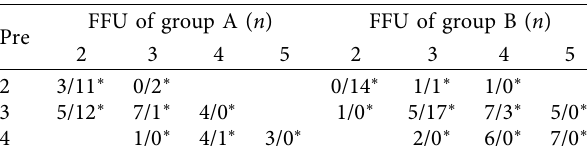
Table 3: Pfirrmann